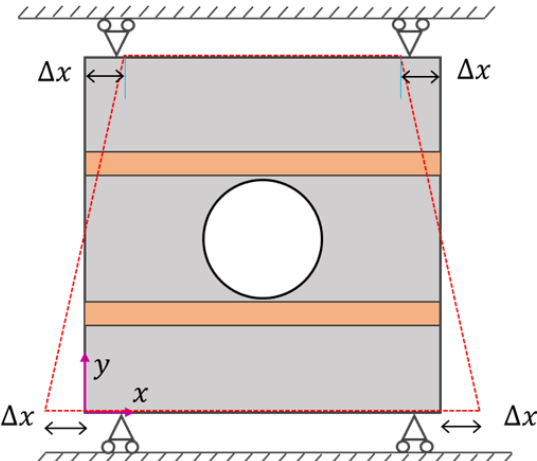
Figure 18. Composite stiffened plate under pure in-plane bending